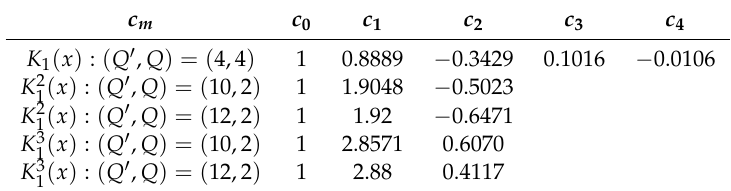
Table 2. Coefficients c m in (34) with different Q (cid:48) and Q